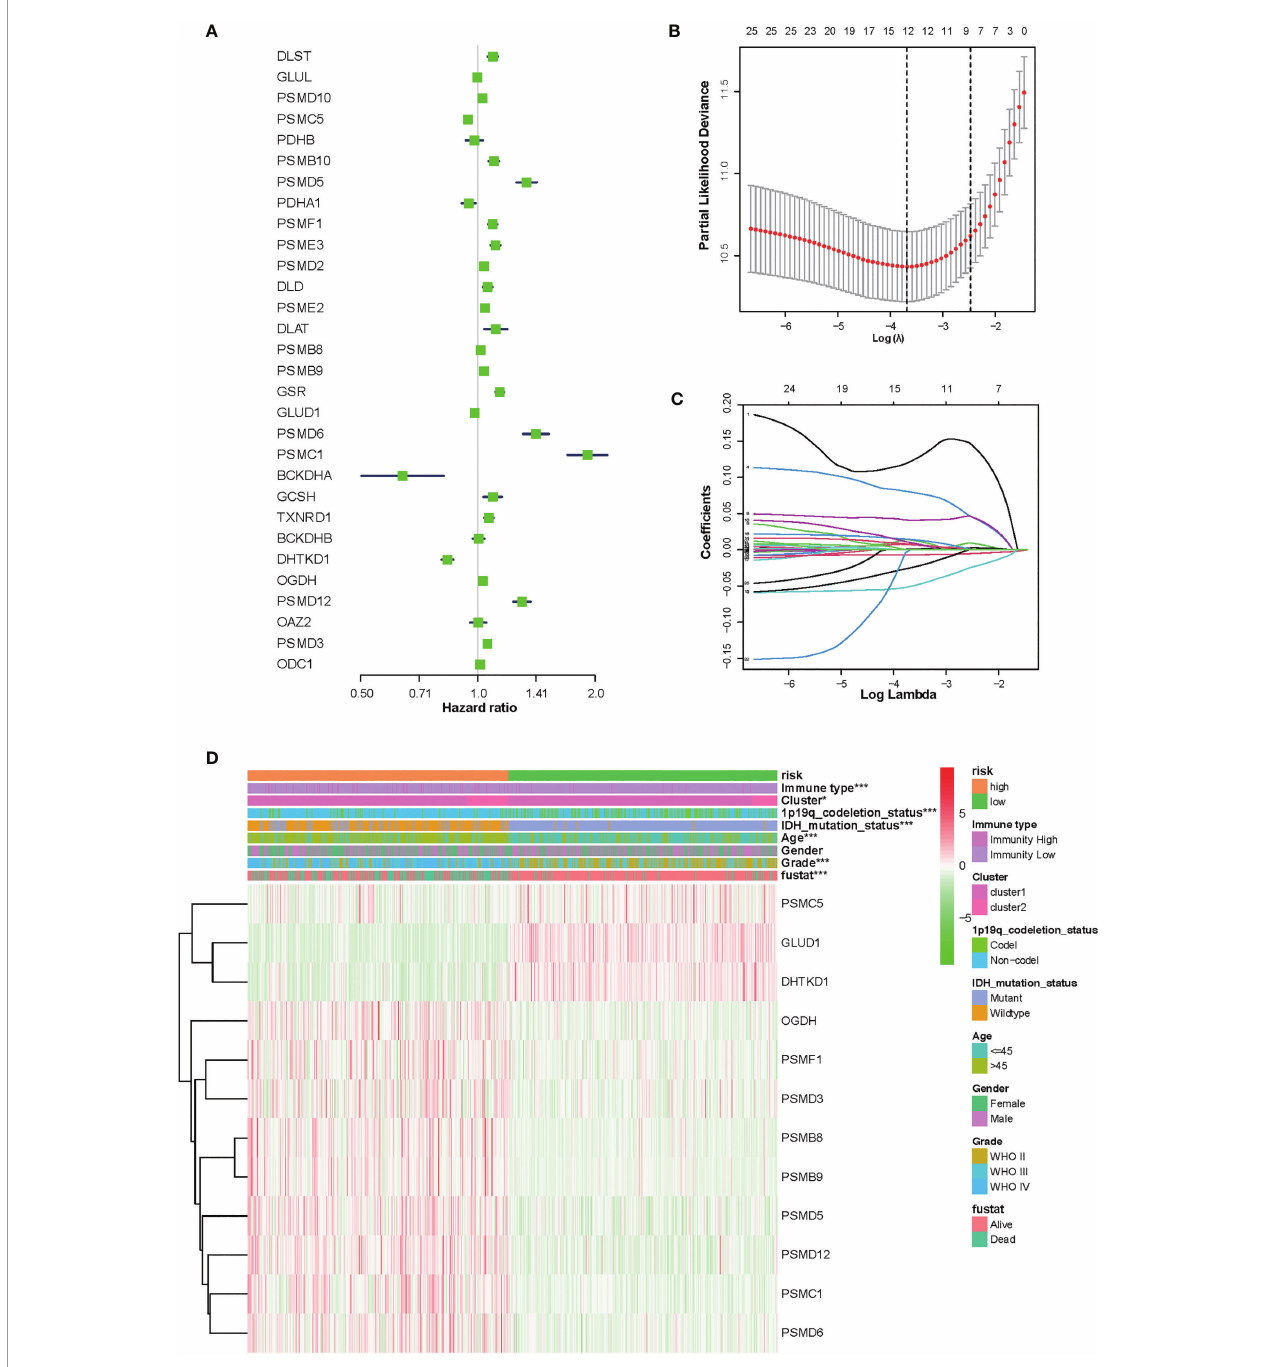
FIGURE 3 | Identi fi cation of 12-gene risk signature for overall survival (OS) by least absolute shrinkage and selection operator regression analysis in the Chinese Glioma Genome Atlas datasets. (A) Thirty genes associated with OS of patients with glioma by univariate Cox regression analysis. (B) Red dots represent average partial likelihood deviances for every model with a given lambda, and vertical bars indicate the upper and lower values of the partial likelihood deviance errors. The vertical black dotted lines de fi ne the optimal values of lambda, which provides the best fi t. Survival curves of patients in the high-risk group and the low risk group of The Cancer Genome Atlas glioma cohort. (C) The selection of the tuning parameter (lambda) in the least absolute shrinkage and selection operator model by 10-fold cross-validation based on minimum criteria for OS; the lower X axis shows log (lambda), and the upper X axis shows the average number of OS genes. The Y axis indicates partial likelihood deviance error. (D) Heat map showing the association of risk scores and clinical pathology features based on the 12-gene risk signature. *P < 0.05, ***P <